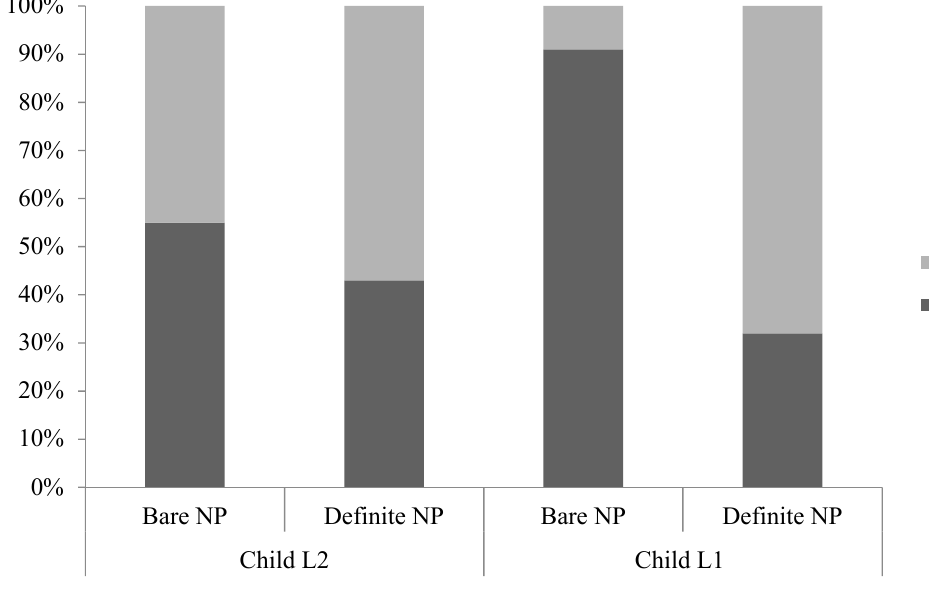
Figure 2. Interpretation of bare NPs and definite NPs by L2 and L1 children.